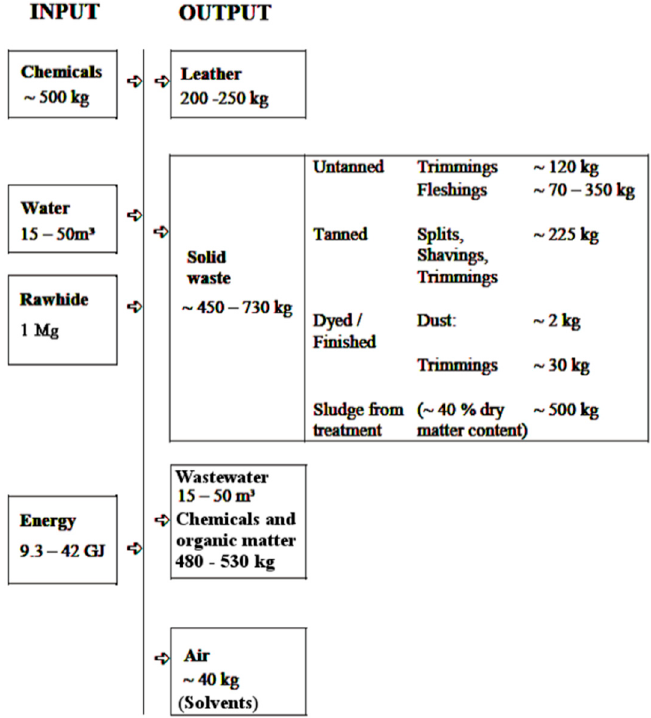
Figure 1. Input / output overview of a conventional chrome-tanning process for bovine salted hides per 1 Mg of raw hide processed [5].